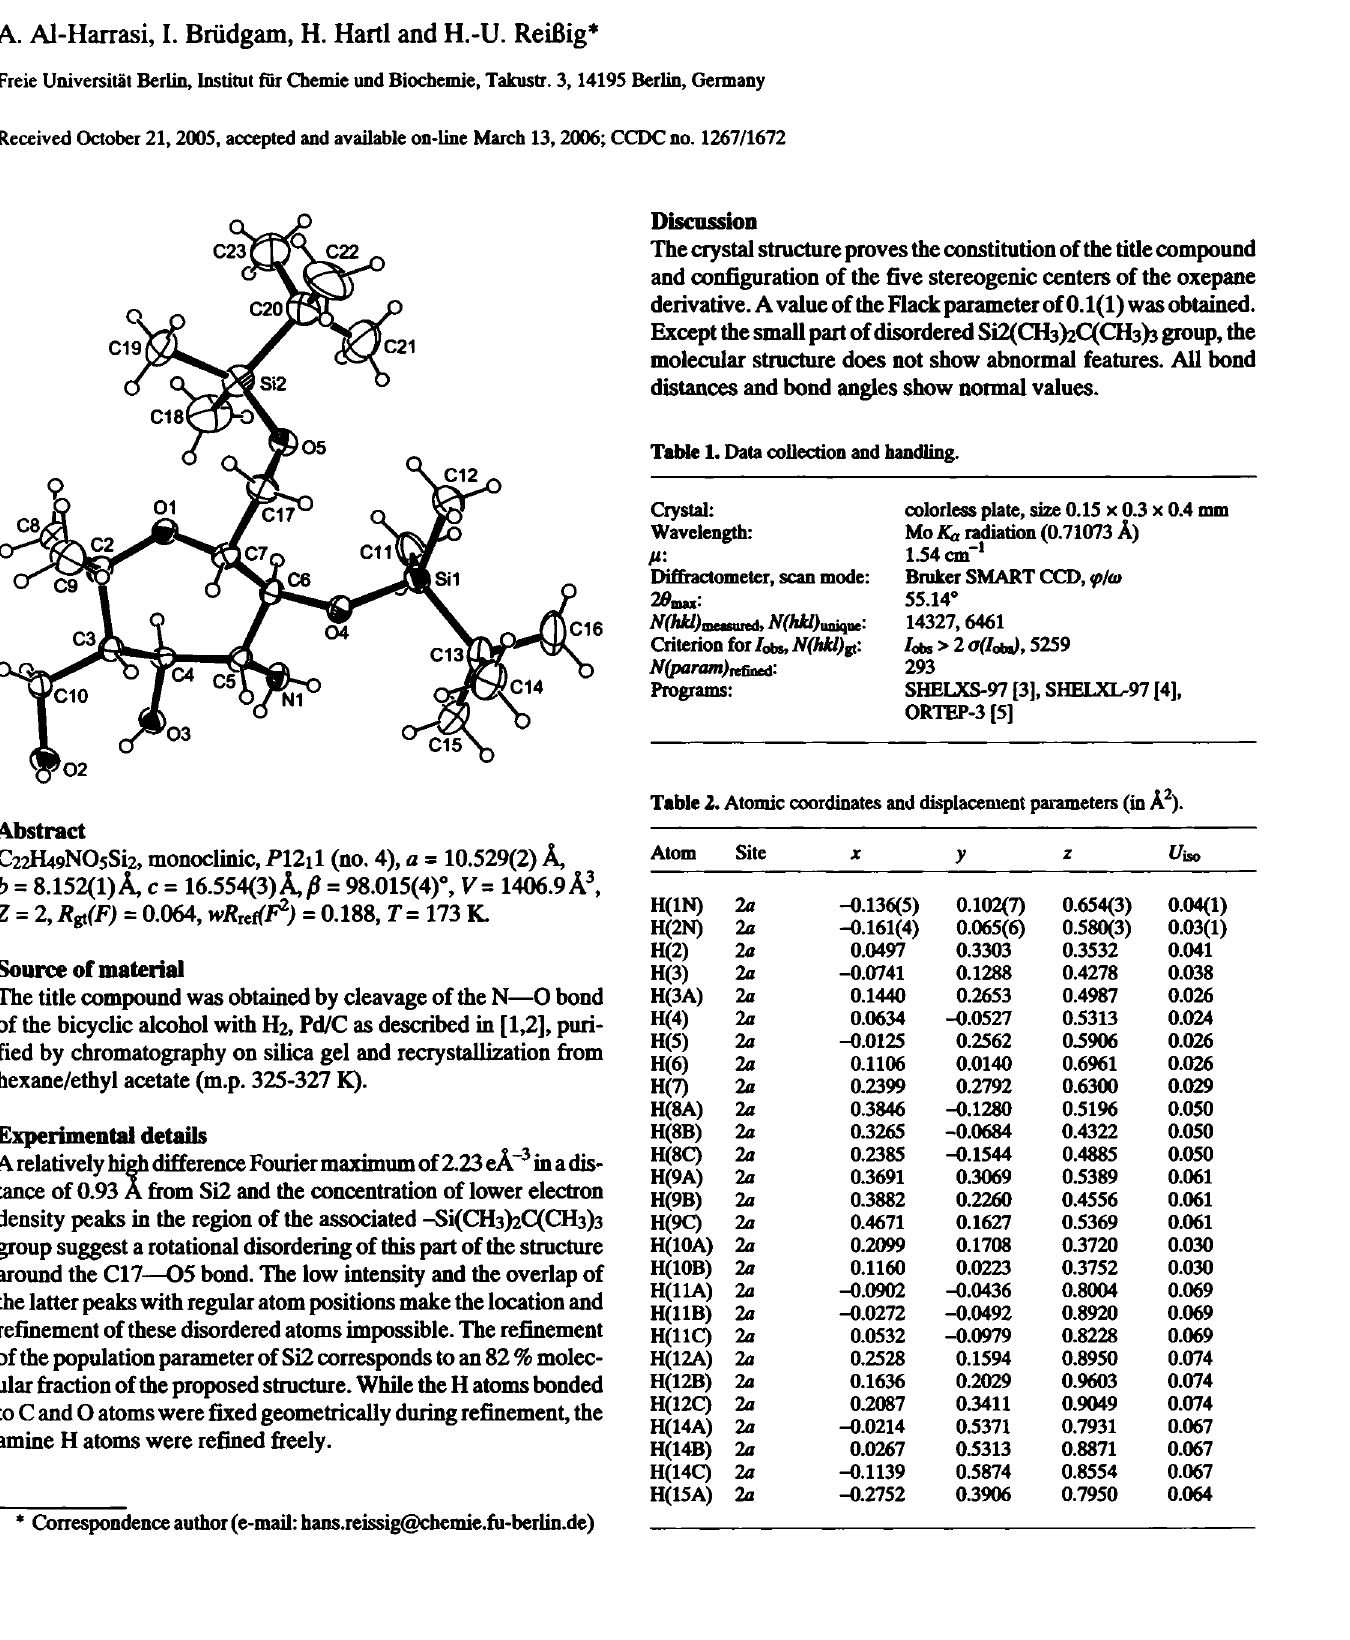
Table I. Data collection and handling.